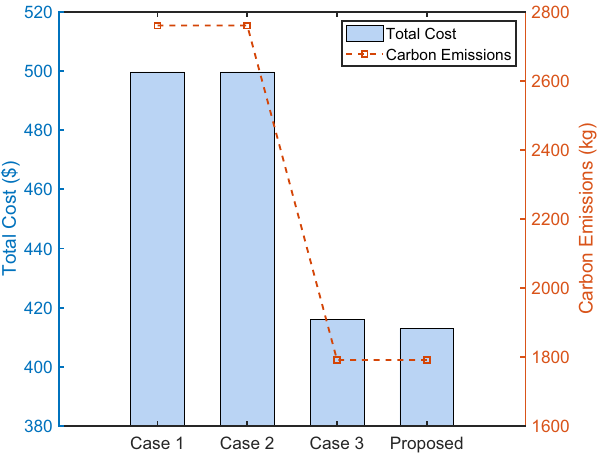
Figure 12. Comparison results under different market